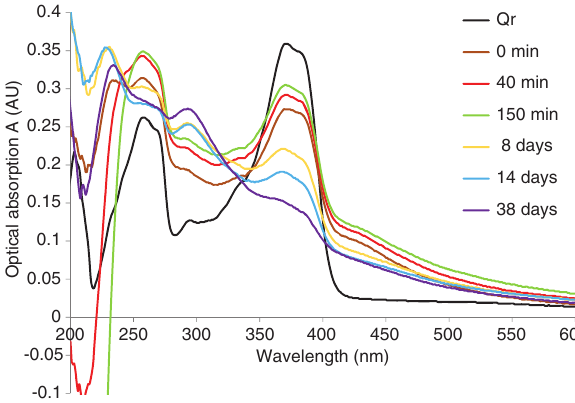
Figure 7 The optical absorption spectra of Rh/Pd Chem NPs in = 1.0 (lower curve) and ω = 5.0 reversed micellar solutions ( ω = 5.0) at different moments. Quercetin 1 2 spectrum is given for comparison of NPs